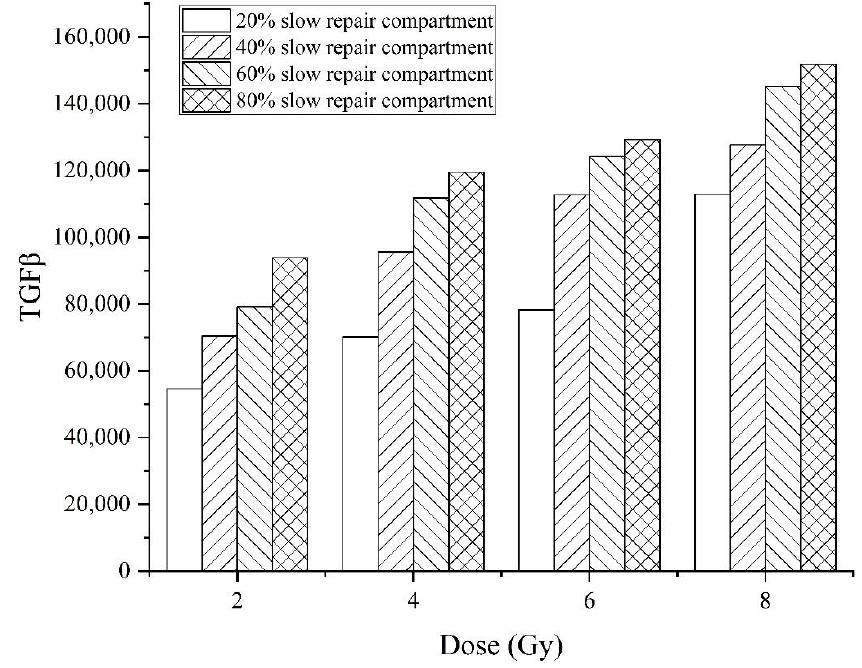
Figure 5. TGFβ secreting in the conditions of exposure to 2 – 8 Gy dose irradiation and repaired by Figure 5. TGF β secreting in the conditions of exposure to 2–8 Gy dose irradiation and repaired by 20 – 80% slow repair compartment. 20–80% slow repair compartment.